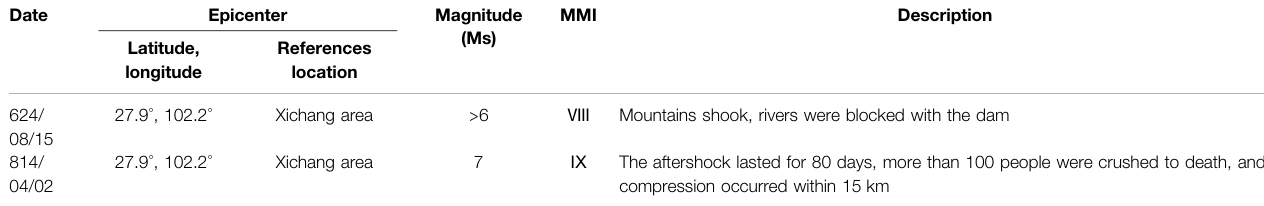
TABLE 4 | Historical earthquakes before 878 AD in Xichang-Dongchuan